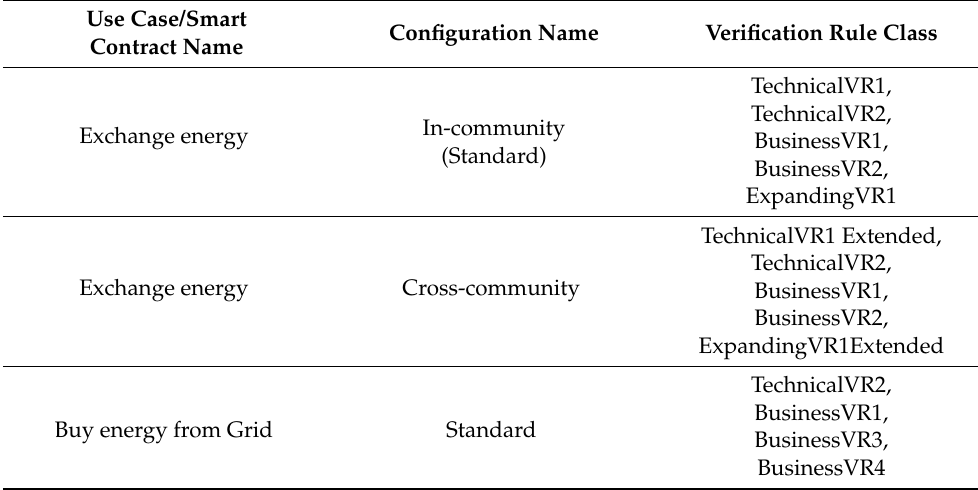
Table 1 contains a summary of configurations with specific verification rules. Table 1. Configurations with verification rules classes.